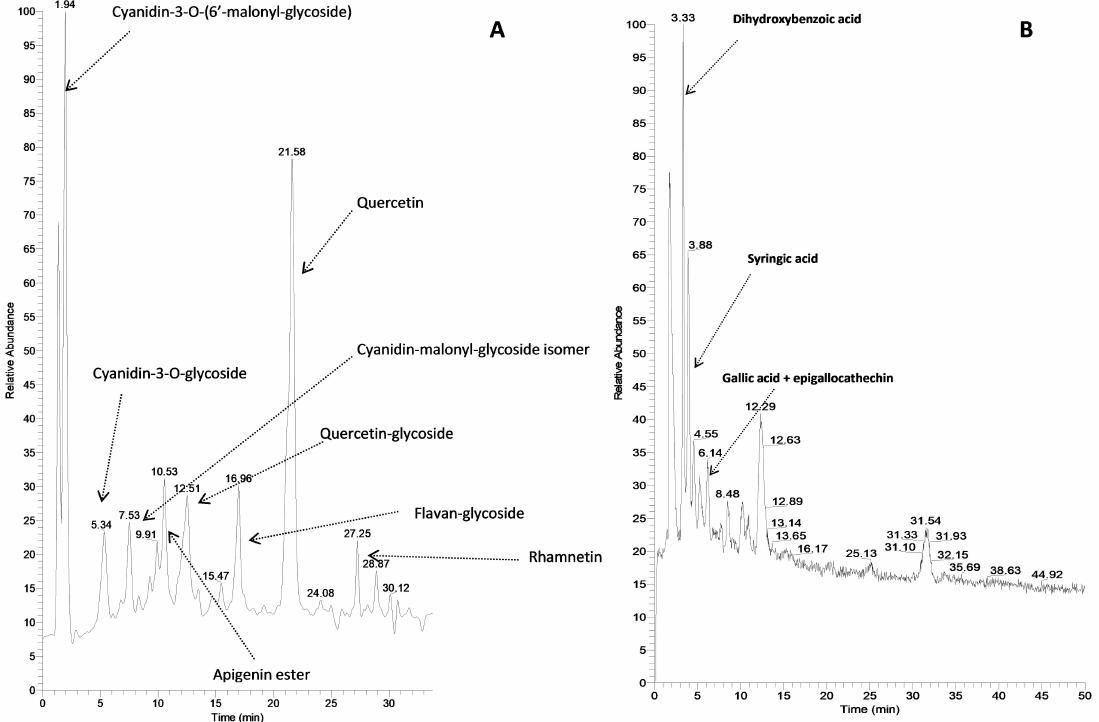
Figure 2. ( A ) Chromatographic separation of OLE constituents monitored in full mass ion positive mode and ( B ) chromatographic separation of OLE constituents monitored in full mass ion negative mode.